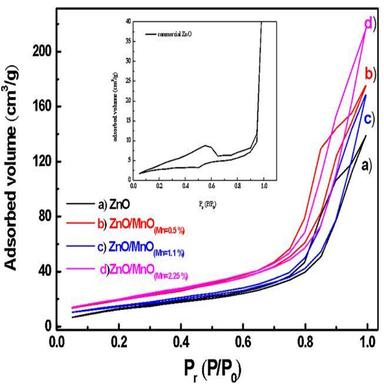
Adsorption-desorption isotherm of a) ZnO and ZnO/MnO with b) Mn = 0.5%, c) Mn = 1.1% and d) Mn = 2.25%). Inset: Commercial ZnO sample.